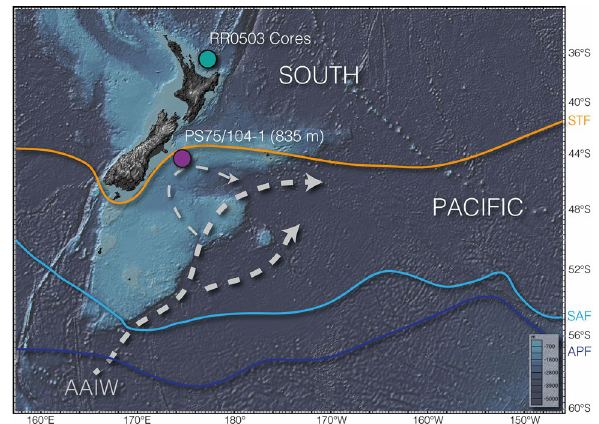
Figure 1. Schematic view of Southwest Pacific research area and oceanographic features important to this study. Purple dot—location of PS75/104-1; teal dot Bay of Plenty core locations used by Allen et al. 39,52 ; AAIW Antarctic intermediate water; orange line—STF/subtropical front; light blue line—SAF/subantarctic front; dark blue line—APF/Antarctic polar front. Fronts according to Orsi et al. 71 . AAIW path (grey arrows) according to Bostock et al. 12 . Map created with GeoMapApp version 3.6.12 (https:// www. geoma papp. org).